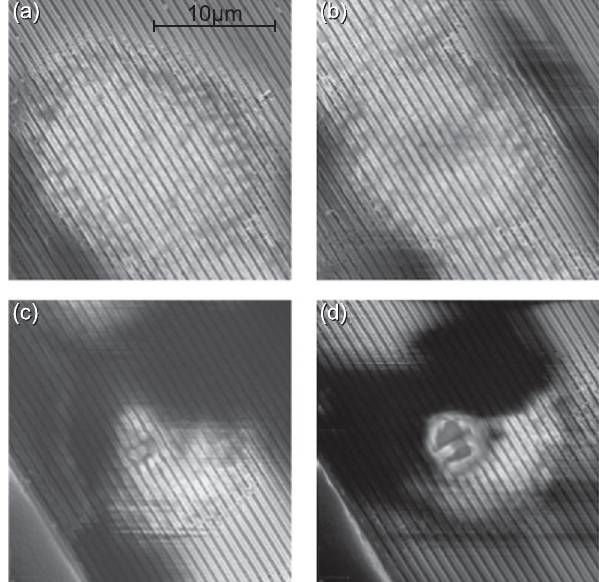
FIG. 4. Laser damage threshold measurement of a fused silica grating (10 nm gold coated) performed under high vacuum ( ∼ 10 − 6 mbar). Shown are scanning electron microscope images of the grating after irradiation with laser pulses for less than a minute. All four measurements are performed at different locations of the grating, which instantly experienced the full laser power, i.e., there was no slow ramp up of the power. (a) Ablation of gold coating and formation of gold nanoparticles around the laser focus. Laser parameters: average power P ¼ 400 mW, peak electric field E ¼ 6 . 1 GV = m, peak intensity p I ¼ 1 . 0 × 10 13 W = cm 2 , peak fluence F ¼ 0 . 37 J = cm 2 . p p (b) Small visible distortion of the grating in the beam ¼ 6 . 9 GV = m, center. Laser parameters: P ¼ 500 mW, E p I ¼ 1 . 3 × 10 13 W = cm 2 , F ¼ 0 . 47 J = cm 2 . (c) Visible strong p p damage to the grating. Laser parameters: P ¼ 550 mW, E ¼ 7 . 2 GV = m, I ¼ 1 . 4 × 10 13 W = cm 2 , F ¼ 0 . 51 J = cm 2 . p p p (d) Melting of fused silica. Laser parameters: P ¼ 620 mW, E ¼ 7 . 6 GV = m, I ¼ 1 . 5 × 10 13 W = cm 2 , F ¼ 0 . 57 J = cm 2 . p p p The large dark areas in (c) and (d) indicate surface